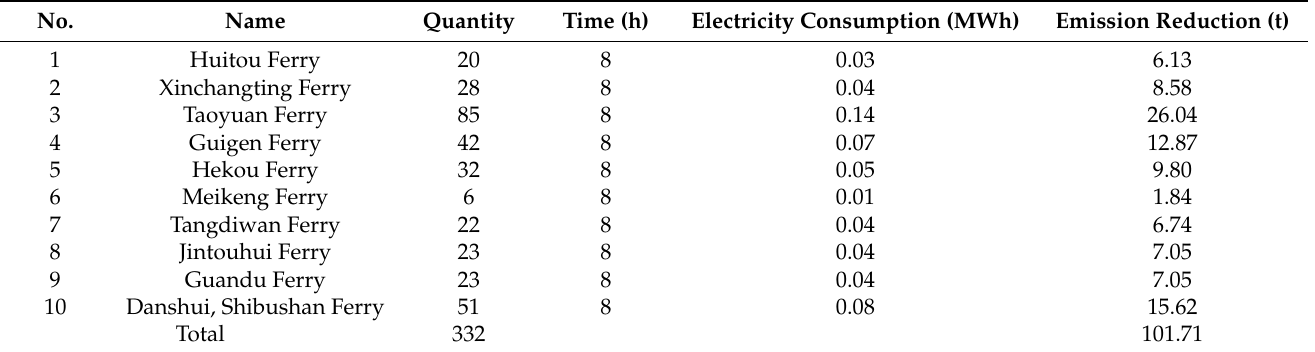
Table 6. Emissions reduction from solar light installation on the